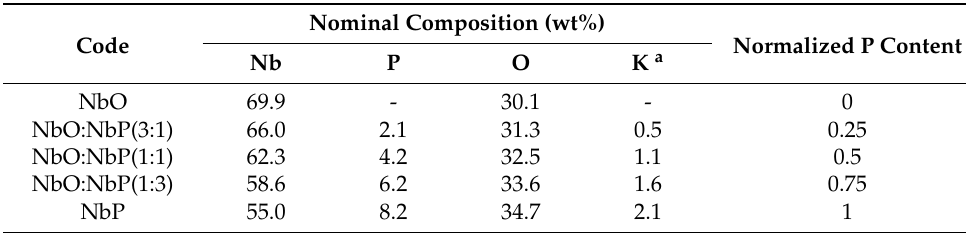
Table 1. Composition of niobium-based catalysts.